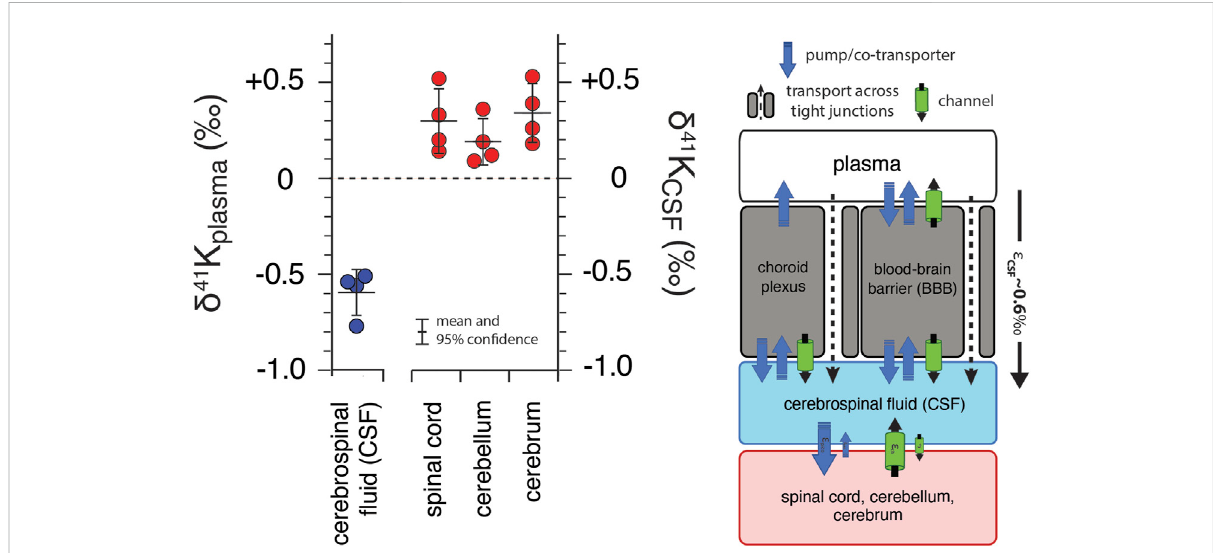
FIGURE 4 K isotopic composition of cerebrospinal fl uid from R. norvegicus raised on a controlled diet (vivarium chow) normalized to blood plasma ( δ 41 K plasma = 0 ‰ ) and brain tissues normalized to cerebrospinal fl uid ( δ 41 K CSF = 0 ‰ ) together with a diagram of K homeostasis across the choroid plexus and blood brain barrier (BBB) from Hladky and Barrand (2016) including transport by (1) K-channels, (2) K-pumps/co-transporters, and (3) transcellularly through pores in tight-junctions. δ 41 K CSF values that are positive indicate that net K transport out of brain tissues (spinal cord, cerebellum, and cerebrum) and into CSF is enriched in 39 K relative to K transport from CSF into these tissues. The negative δ 41 K plasma values for CSF indicate that net K transport into CSF from blood plasma is enriched in 39 K relative to K transport from CSF to blood plasma and re fl ects the fl ux- weighted average of the transporters that dominate K + exchange across both the choroid plexus and